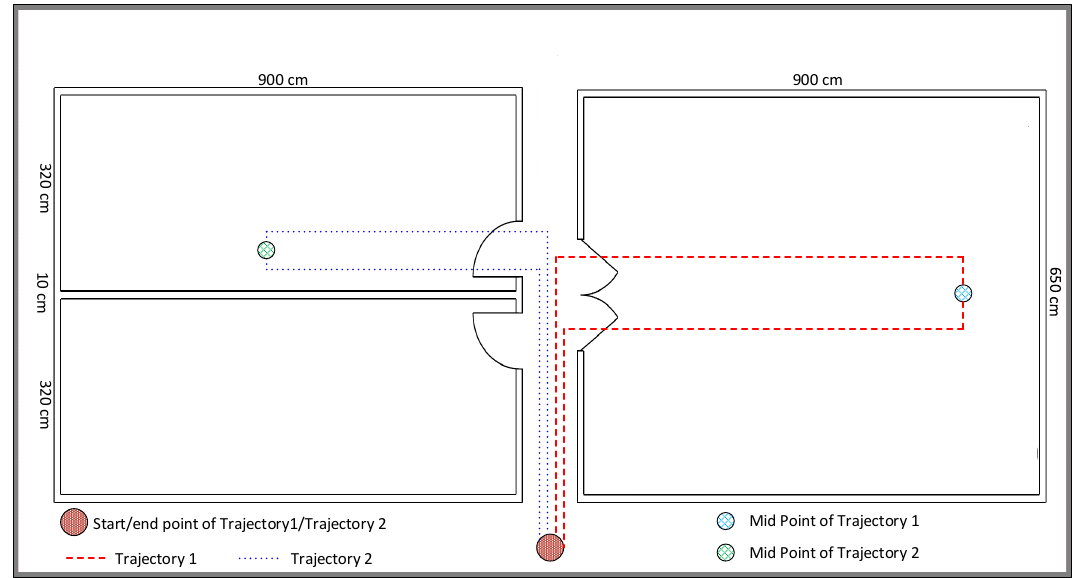
Figure 8. Indoor layout of the